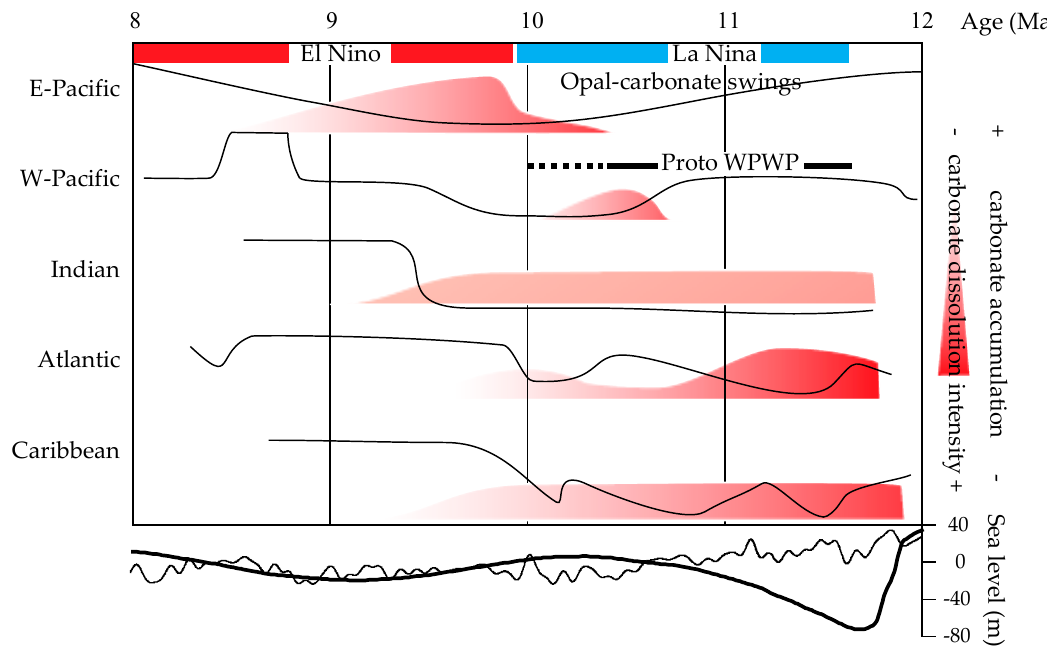
Figure 8. With the CC, the pattern of deep preservation changed in all ocean basins. The CCD rises in the EP and deepened probably first in the deep Atlantic, afterwards in the Caribbean and Indian Ocean. There is no clue to sea level, as a first order control on CC events.